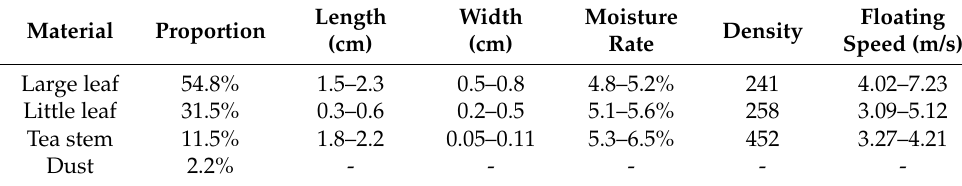
Table 4. Physical parameters of Materials of Lan